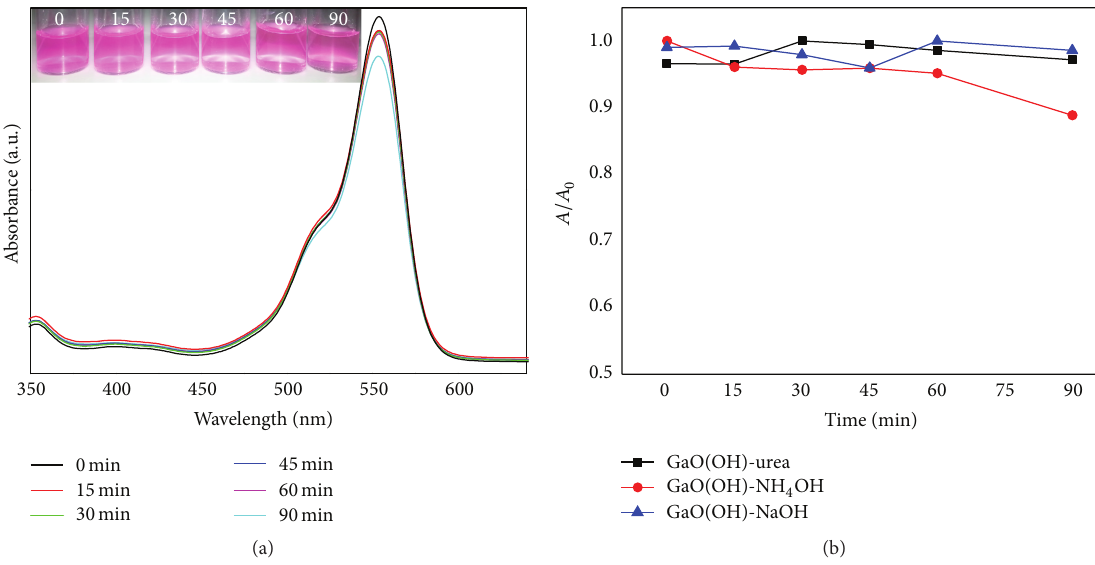
Figure 7: (a) The UV-visible absorption spectra of RhB solution in the presence of GaO(OH) crystals (prepared by the precipitation of GaCl 3 solution with urea) under UVC light (254 nm) irradiation; (b) photodegradation curve of GaO(OH) samples as a function of irradiation